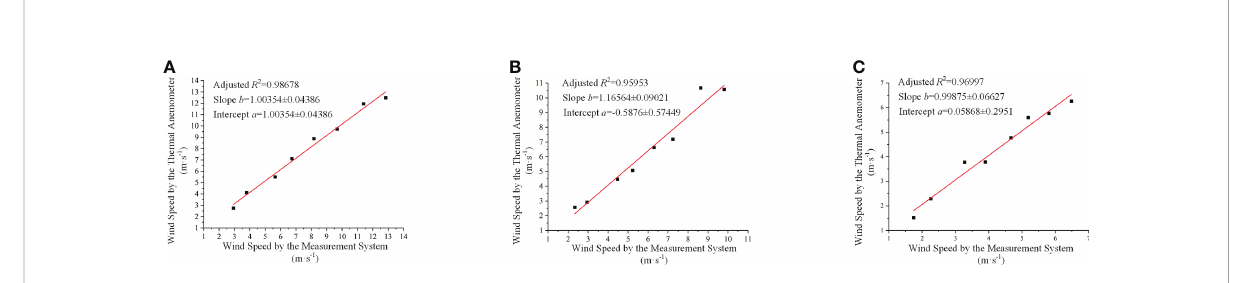
FIGURE 10 The regressions between the thermal anemometer and the measurement system, where (A – C) correspond to Carbon Fibre Tube 1, Carbon Fibre Tube 2 and Carbon Fibre Tube 3,